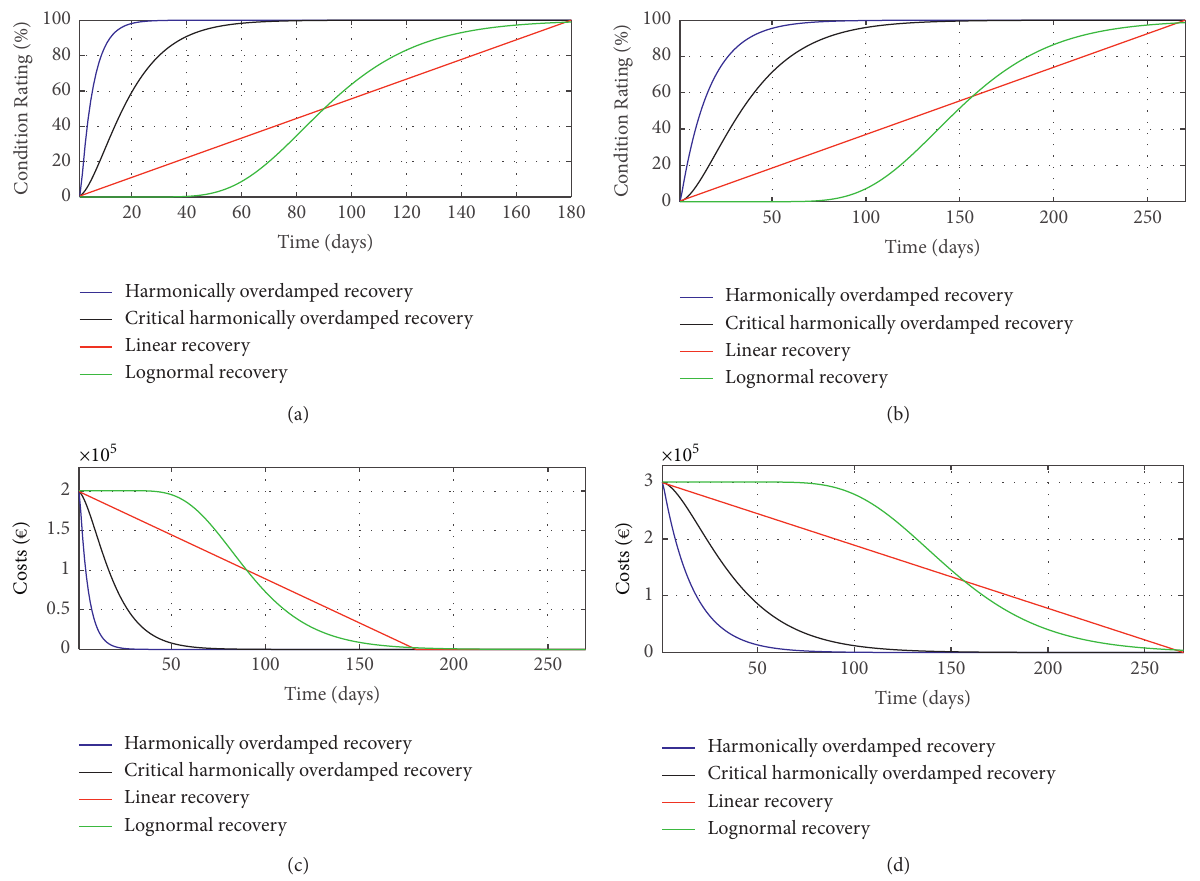
Figure 11: Recovery scenario and consequence estimation for different recovery functions: (a) recovery for 180days; (b) recovery for 270days; (c) consequences for 180days; (d) consequences for 270 days; (e) legend of the recovery functions. Table 14: Resilience estimation using different recovery functions. Recov. time of 180 days (%) Recov. time of 270 days Recovery function